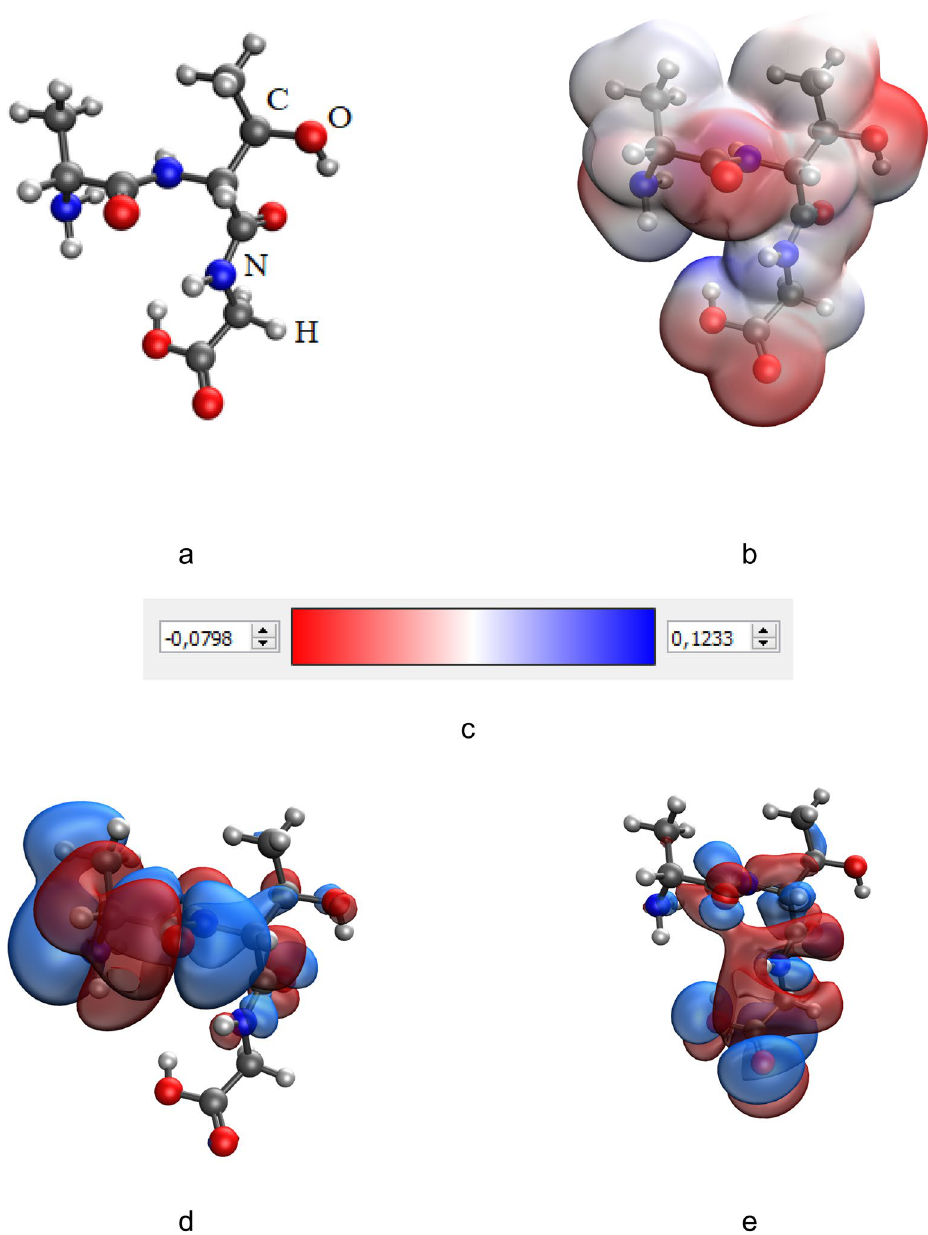
Figure 6. Results of the quantum-chemical simulation of the gelatin segment Ala-Thr-Gly: a model of the molecular complex ( a ), the distribution of electron density ( b ), electronic density distribution gradient ( c ), HOMO ( d ), LUMO ( e